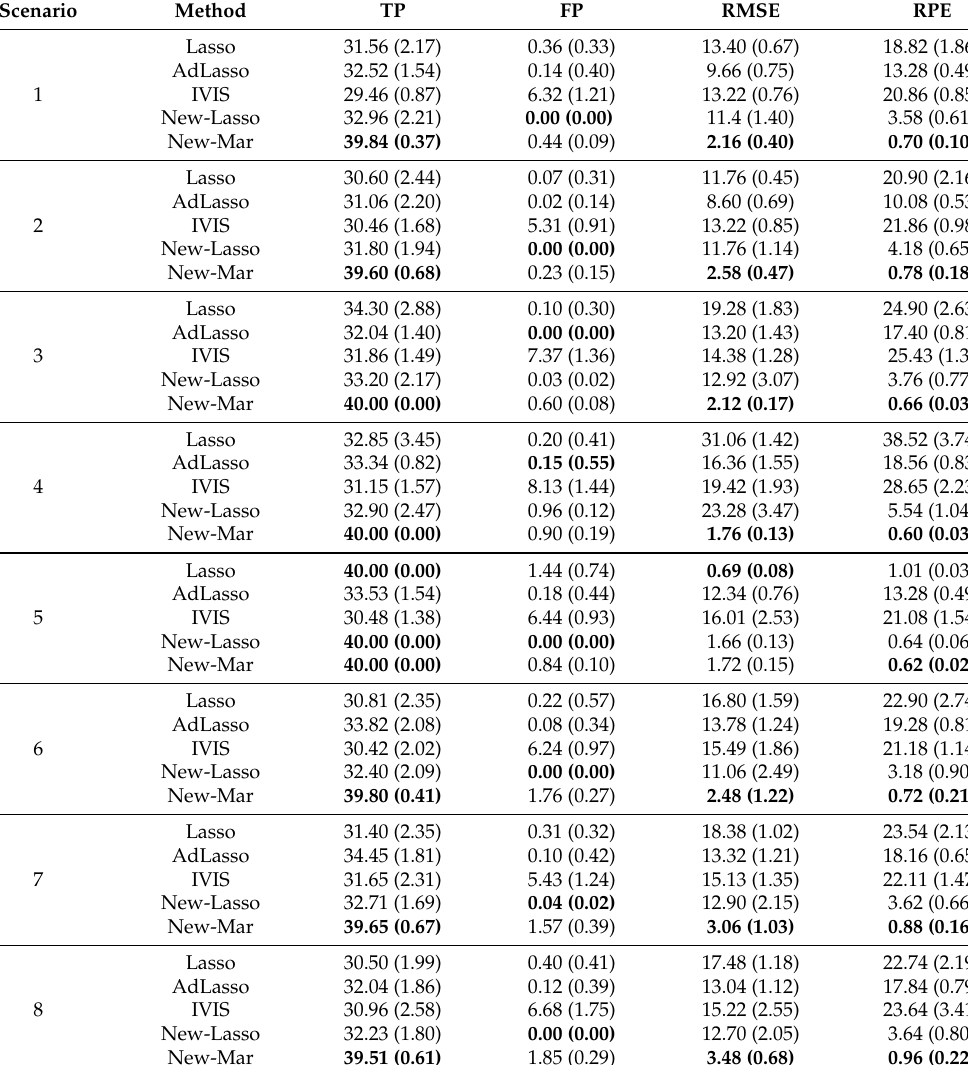
Table A3. Simulation results for N = 200, p = 500, q = 40, and ρ = 0.8. Each cell shows the mean (sd). The bold represents the best value.